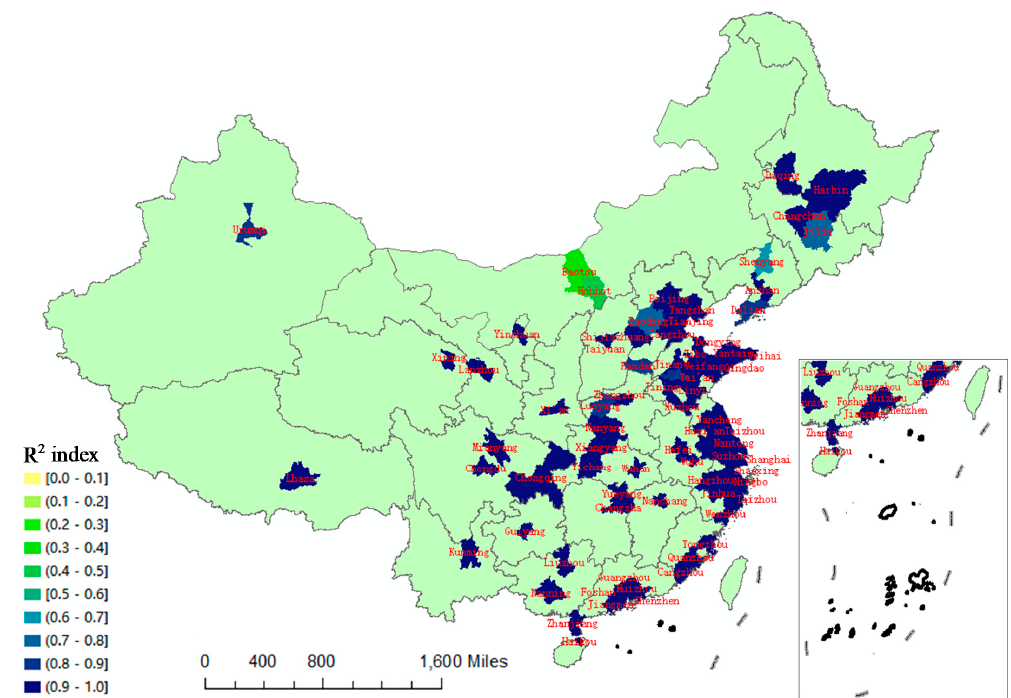
Figure 6. Distribution of R 2 which is calculated by the OSM road network density and population.